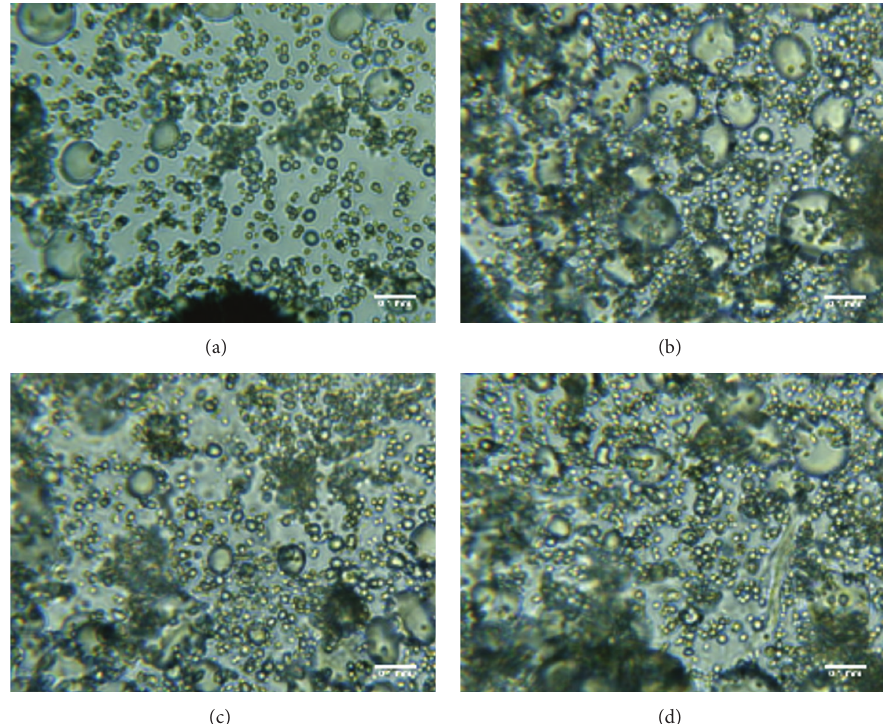
Figure 6: Microscope photographs of barley milk samples blended for (a) 15 seconds; (b) 30 seconds; (c) 45 seconds; and (d) 60 seconds (line is